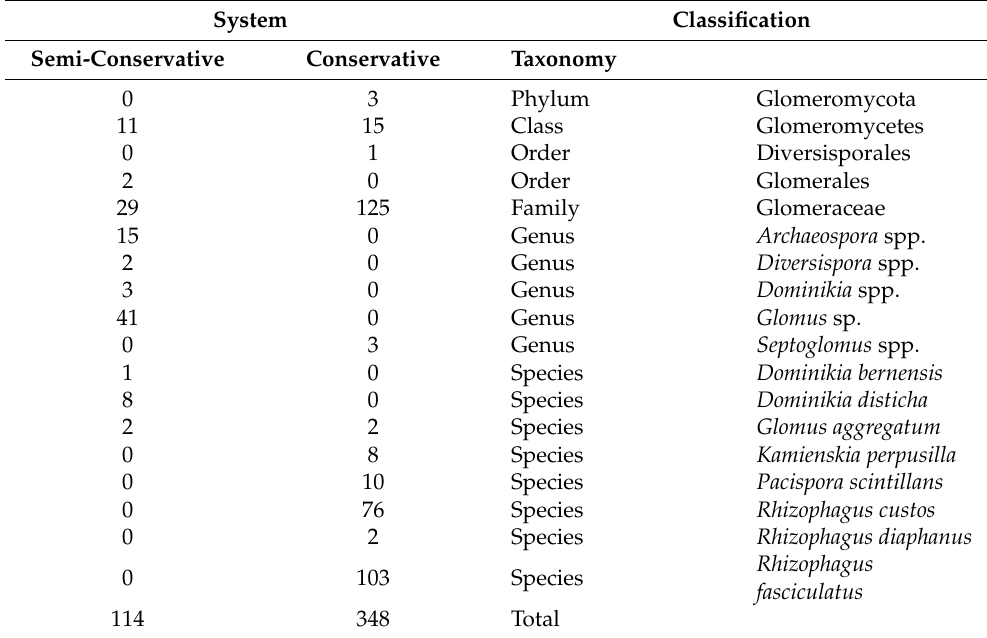
Table 1. Abundance of ASV belonging to arbuscular mycorrhizal fungi detected in conservative and semi-conservative cocoa samples. The taxa were classified by the UNITE